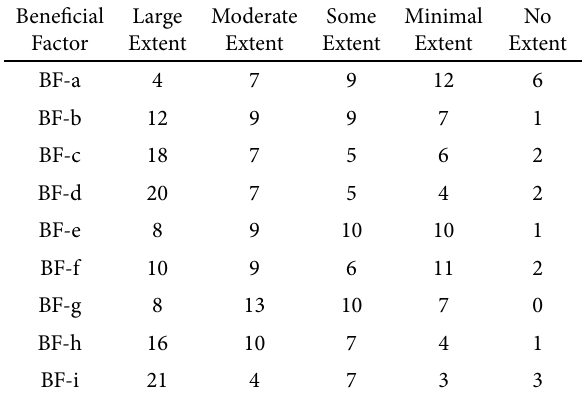
Table 1. Frequency distribution of participant responses to the benefits of implementing EMS in the Nigerian construction industry Beneficial